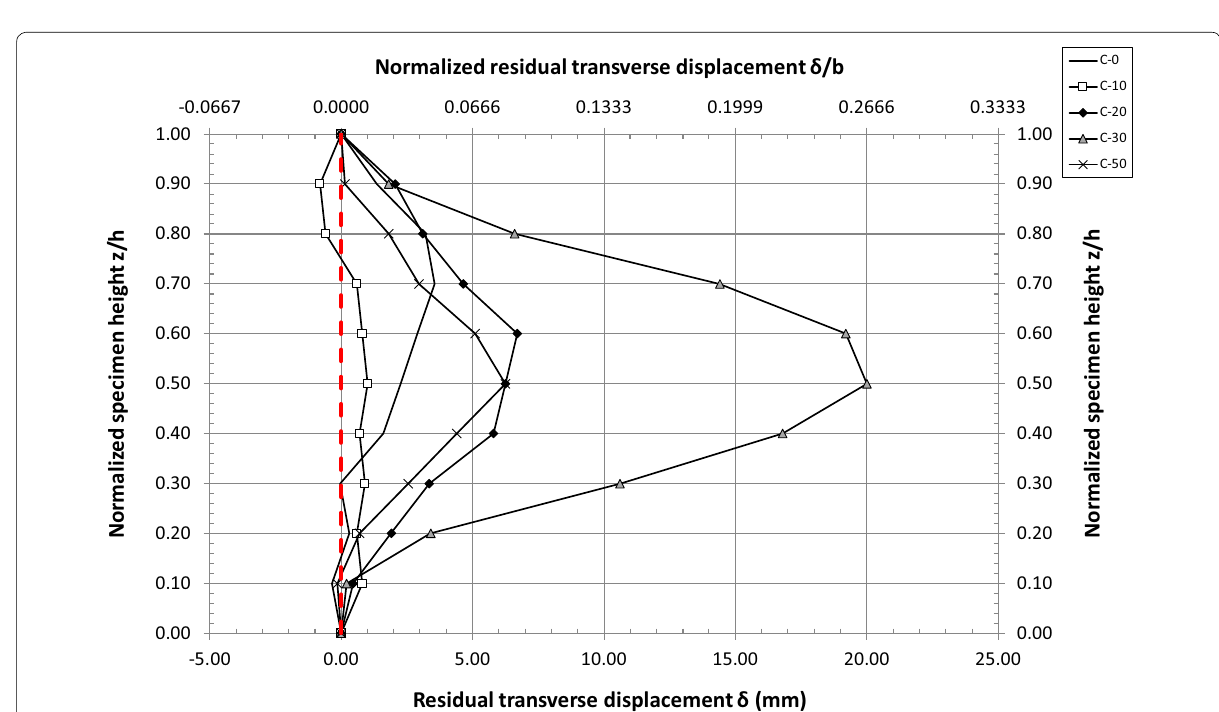
Fig. 9 Variation of normalized specimen height relative to residual transverse